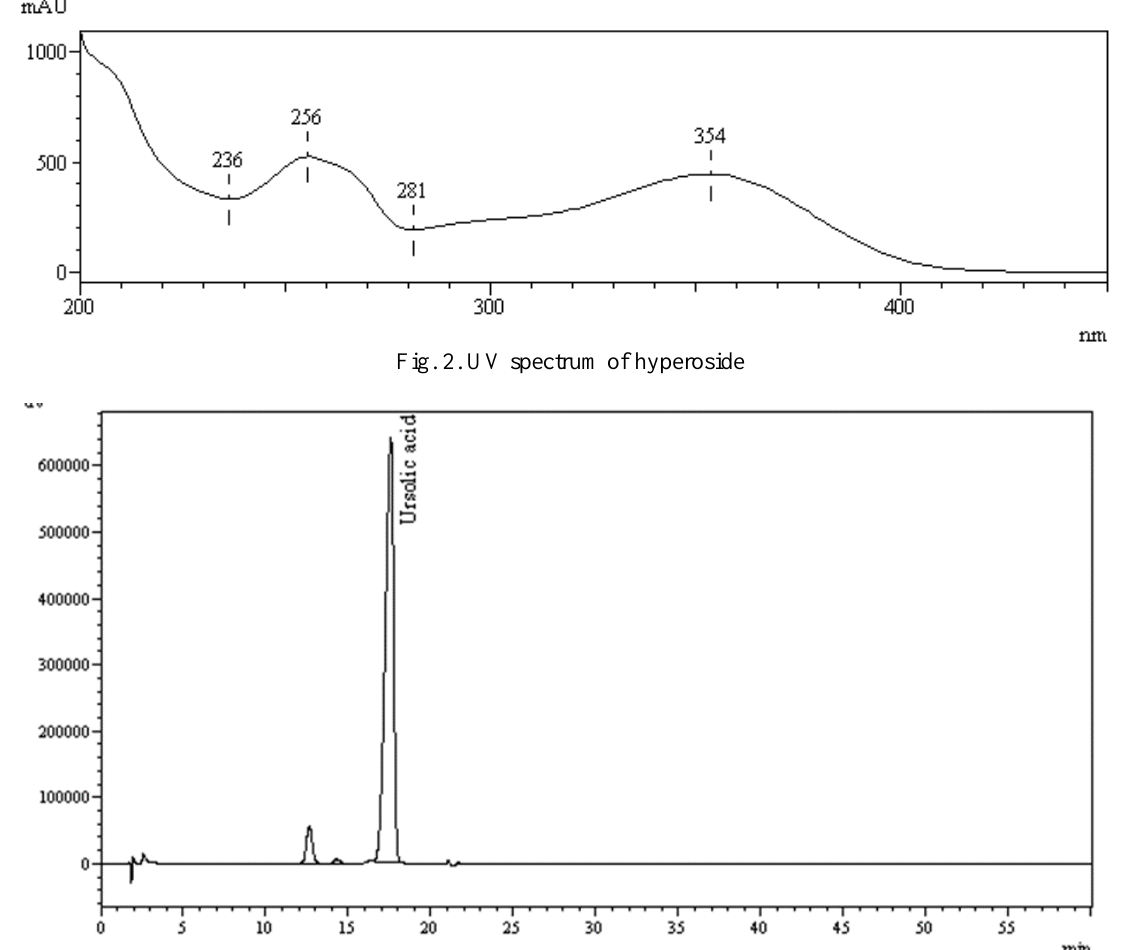
Fig. 3. Chromatogram of ursolic acid